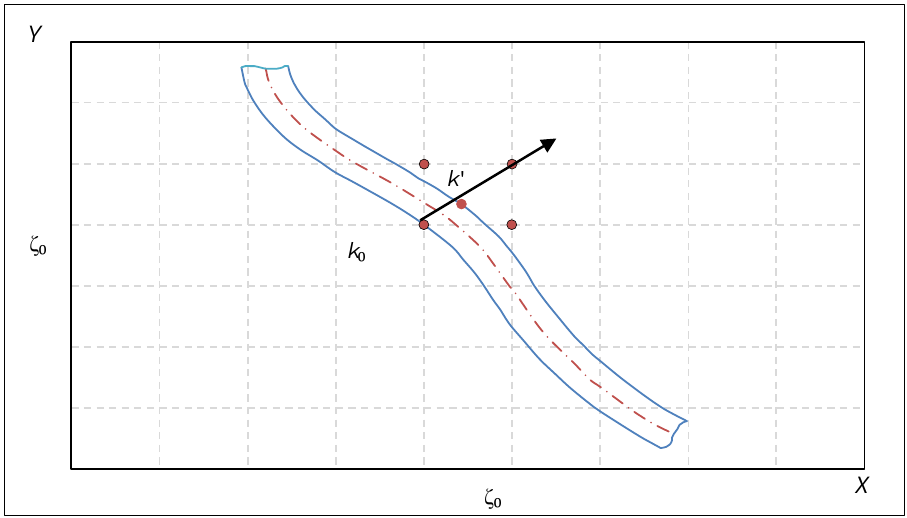
Figure 18. The choice of the coordinates of counts for the contours of the minimum thickness